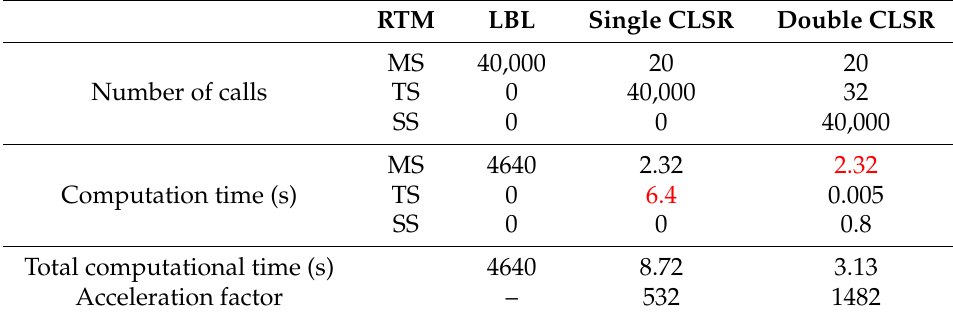
Table 4. Same as for Table 2 but for the water vapour